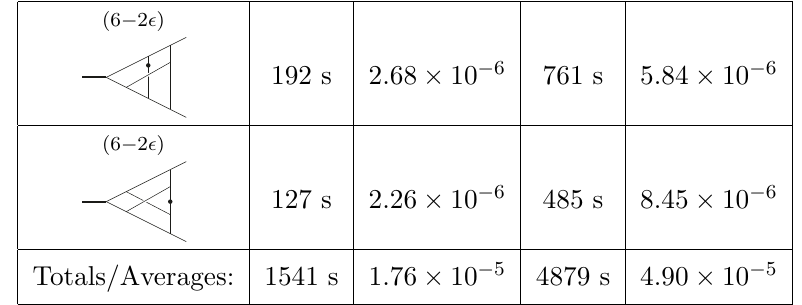
Table 4. Numerical performance of (cid:12)nite master integrals with FIESTA 4 for higher orders in the (cid:15) expansion. On the left, the weight six results of table 3 are reproduced. On the right, results for weight eight are